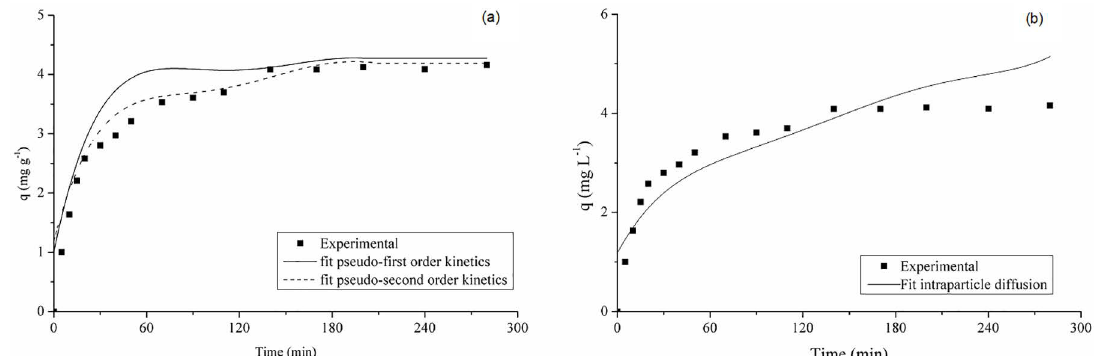
Figure 6. Kinetics of adsorption of tetracycline by Fe nanoparticles. Initial concentration of 30 mg L -1 and 0.5 g of nanoparticles